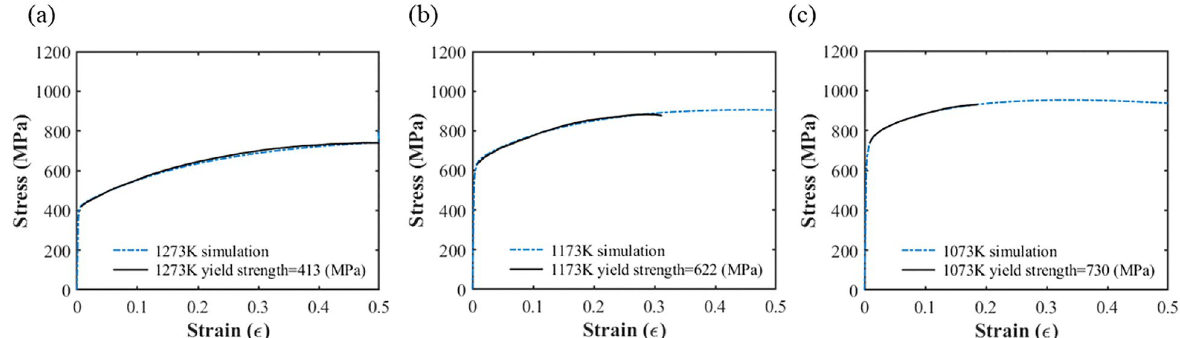
Figure 3. The stress strain curves for the CoCrFeMnNi specimens of different annealing temperatures obtained from numerical simulation: ( a ) 1273 K, ( b ) 1173 K, and ( c ) 1073 K.